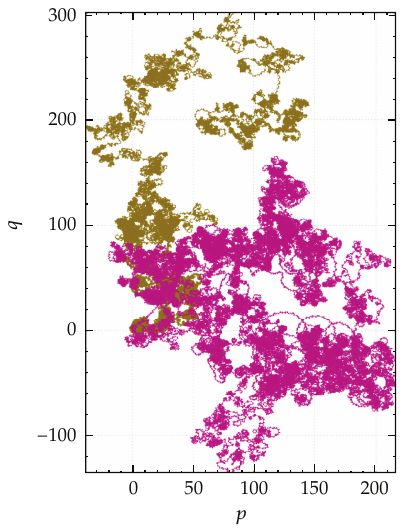
Figure 14: Unbounded Brownian-like orbits at E (cid:7) 20 (cid:5) in 20th-order Hamiltonian (cid:6) . Two chaotic orbits with initial conditions inside and outside (cid:5) in purple and brown, resp. (cid:6) of the cantorus of Family I.